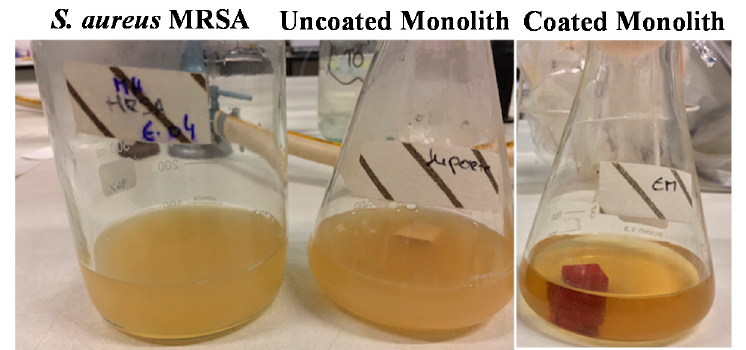
Figure 6. Illustration of the growth inhibition behaviour on the bacterial strain S. aureus MRSA CIP 106760 culture for the uncoated and coated monolithic filter with a silicone-based coating containing tethered Econea biocide (<0.6